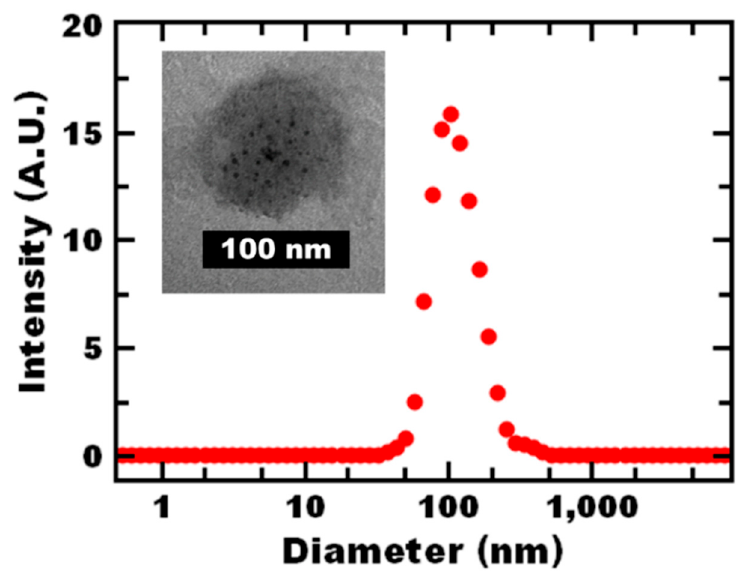
Figure 1. Representative dynamic light scattering (DLS) spectra with a single intensity peak indicative of a uniform castor oil nanoreactor dispersion with representative TEM image as an inset. Gold nanoparticles appear to be incorporated in the nanoreactor; the size is consistent with DLS measurements.